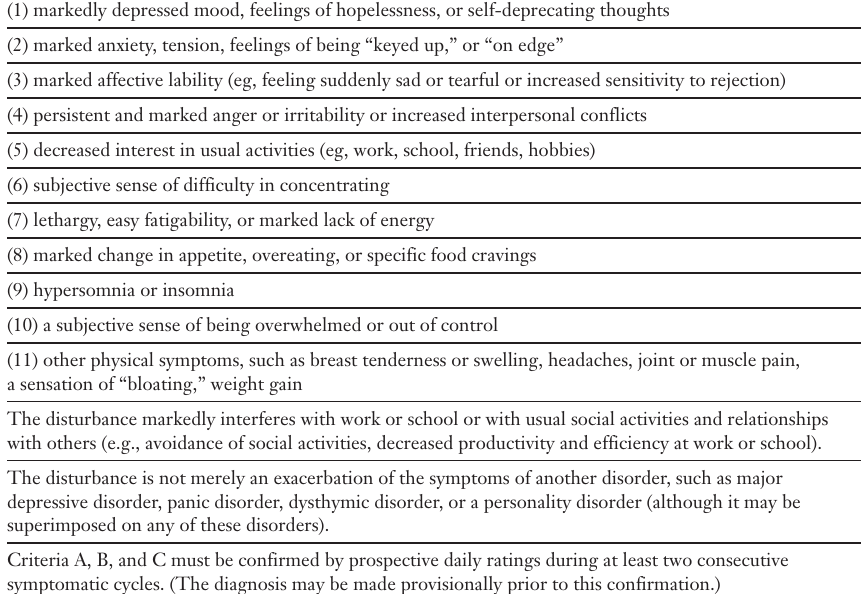
DSM-IV research criteria for premen- strual dysphoric disorder